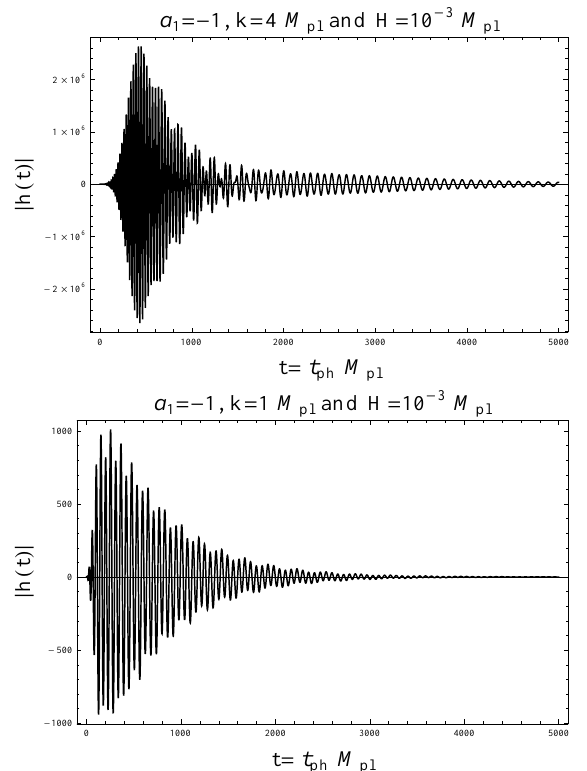
√ t background and transplanckian frequencies, there is an and k = P